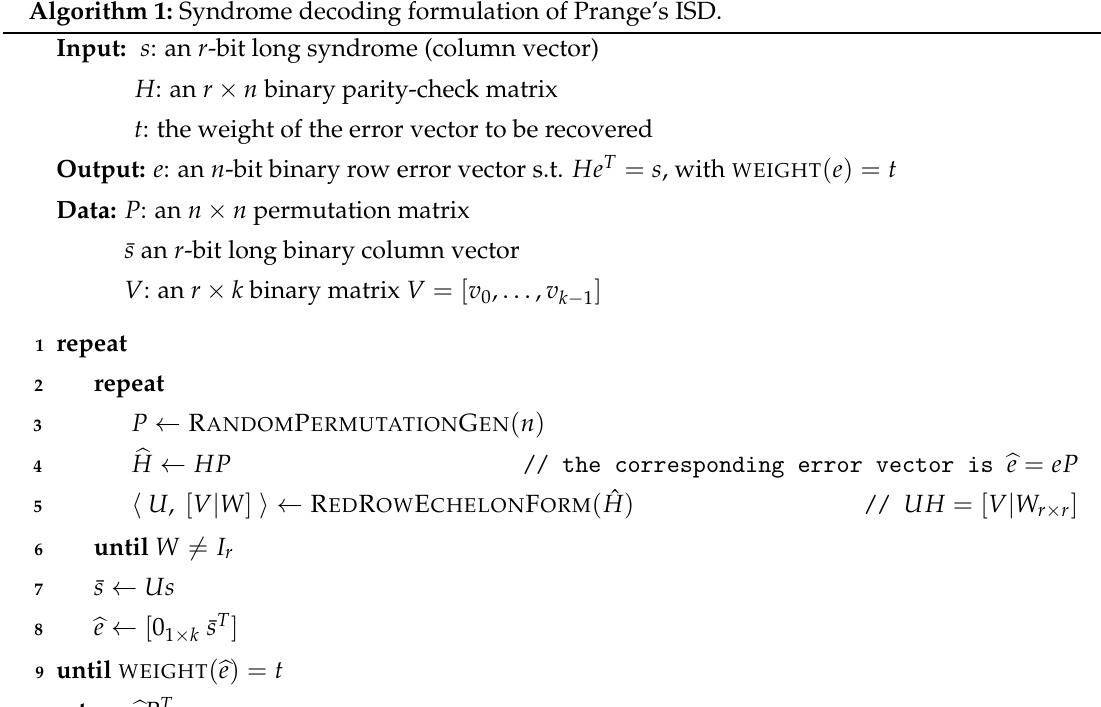
Algorithm 1: Syndrome decoding formulation of Prange’s